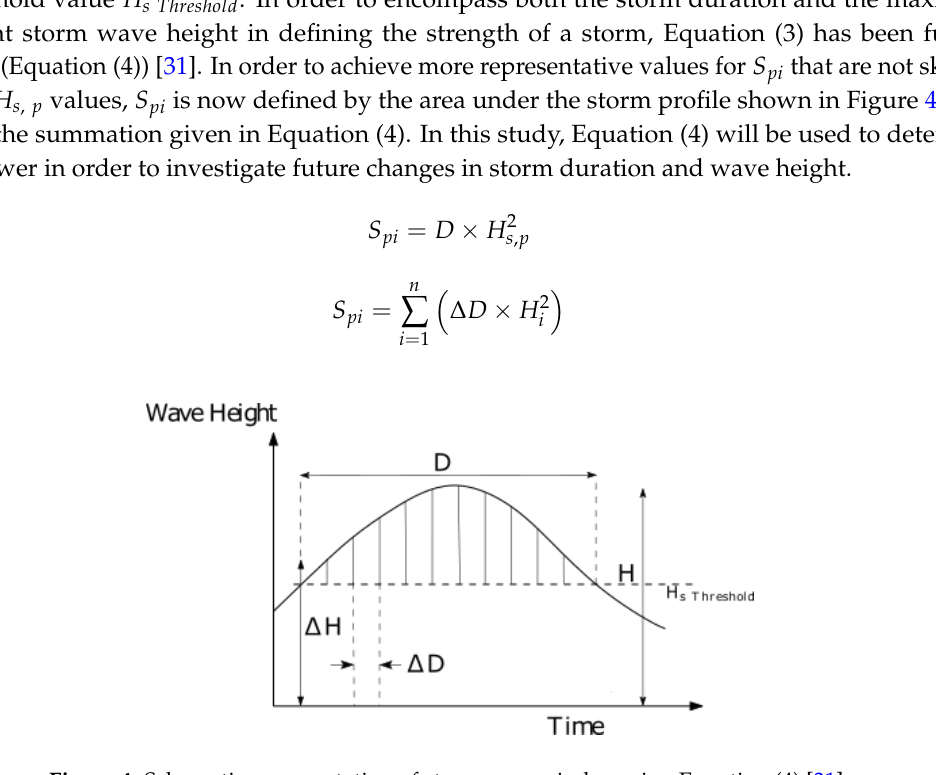
Figure 4. Schematic representation of storm power index using Equation (4) [31].